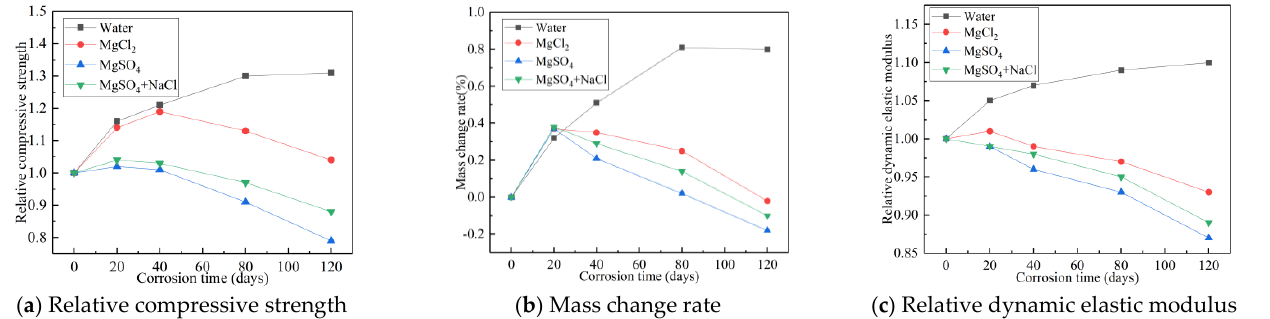
Figure 6. Influences of Mg 2+ on Physical Properties of MK Concrete.